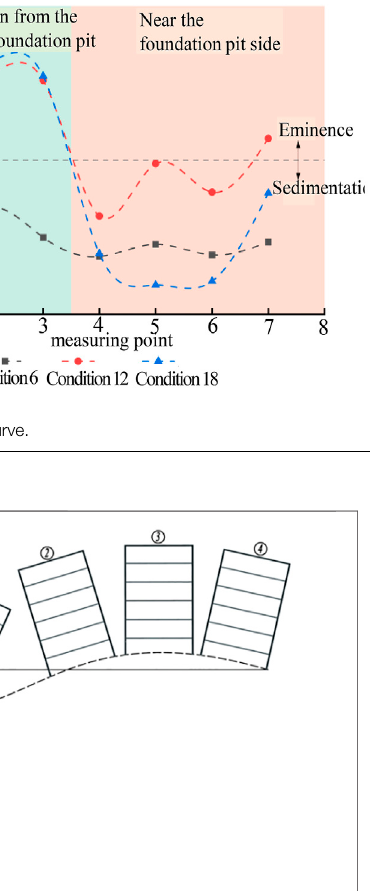
FIGURE 11 | Collapse form of adjacent buildings.